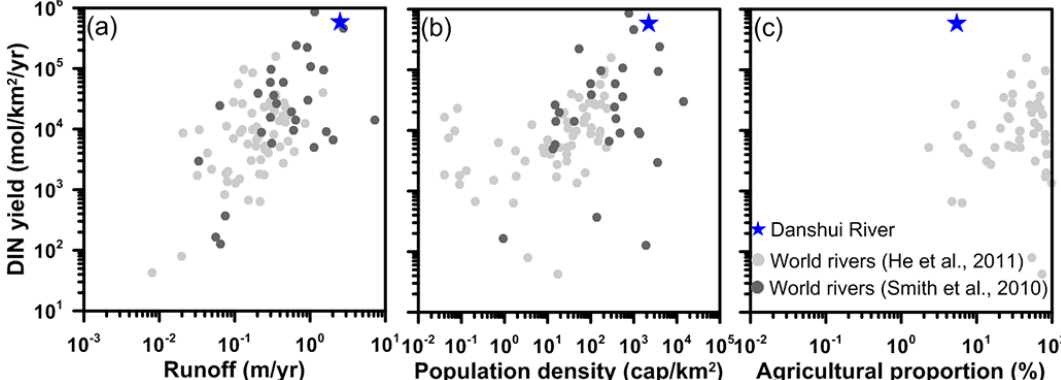
Figure 7. Scatter plots of DIN yields against (a) runoff, (b) population density, and (c) agricultural proportion. The export of the Danshui River (the star symbol) is plotted with global river data (grey circles). World river data are retrieved from He et al. (2011) and Smith et al. (2010).